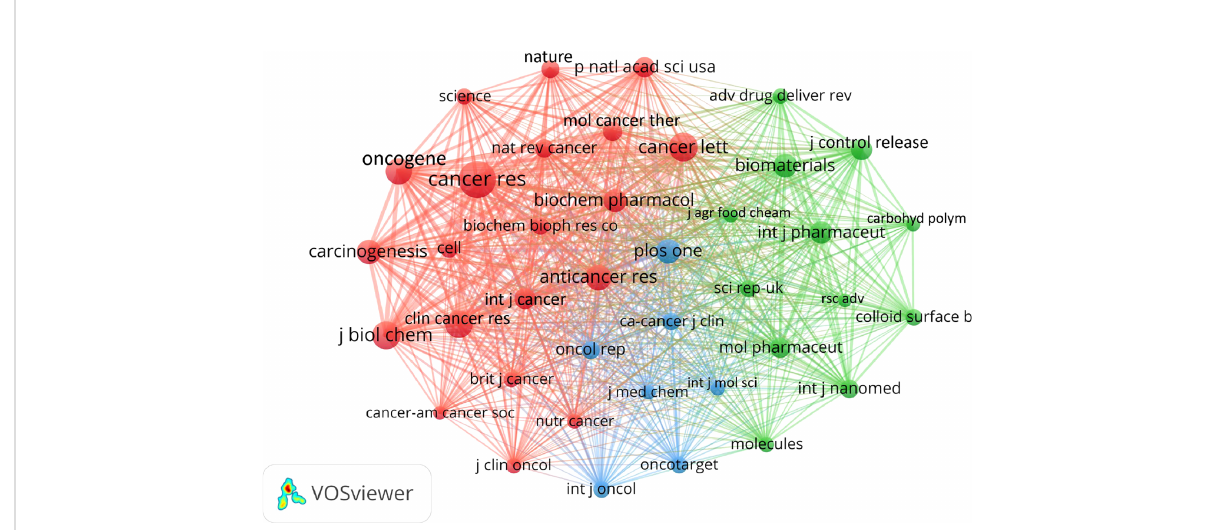
FIGURE 7 Co-cited journals of curcumin and tumor articles were published by vosviewer